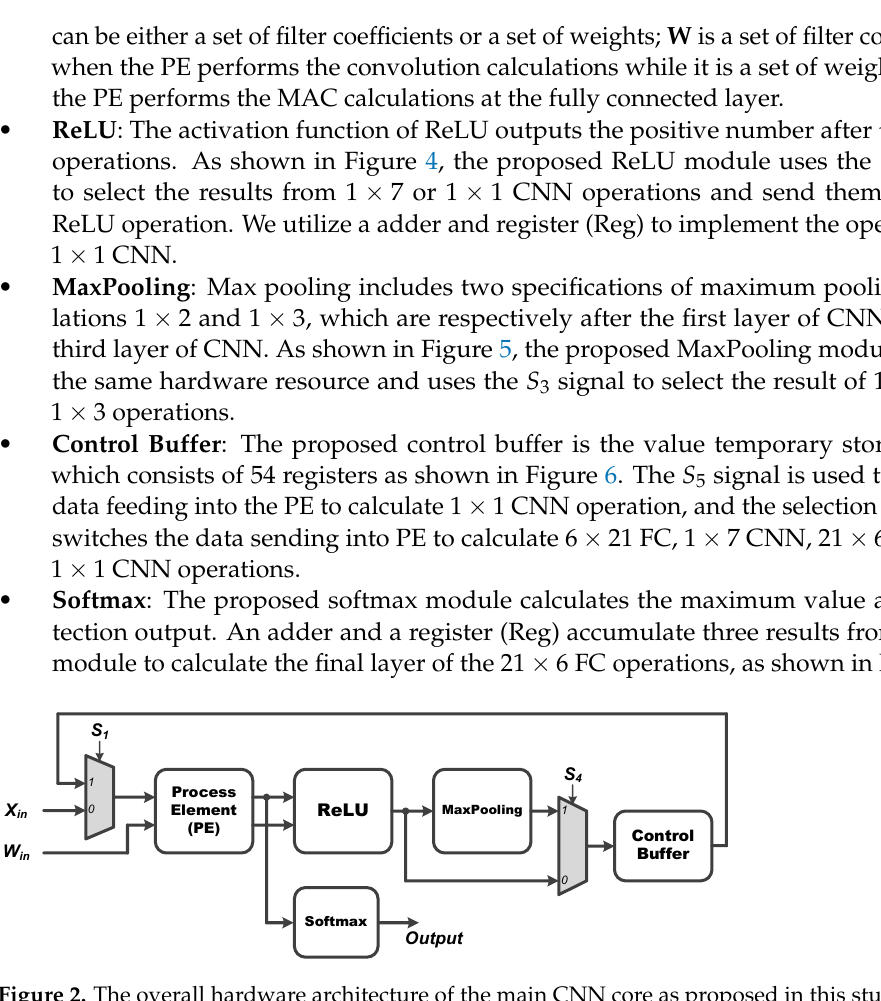
Figure 2. The overall hardware architecture of the main CNN core as proposed in this study. Version January 14, 2022 submitted to MDPI